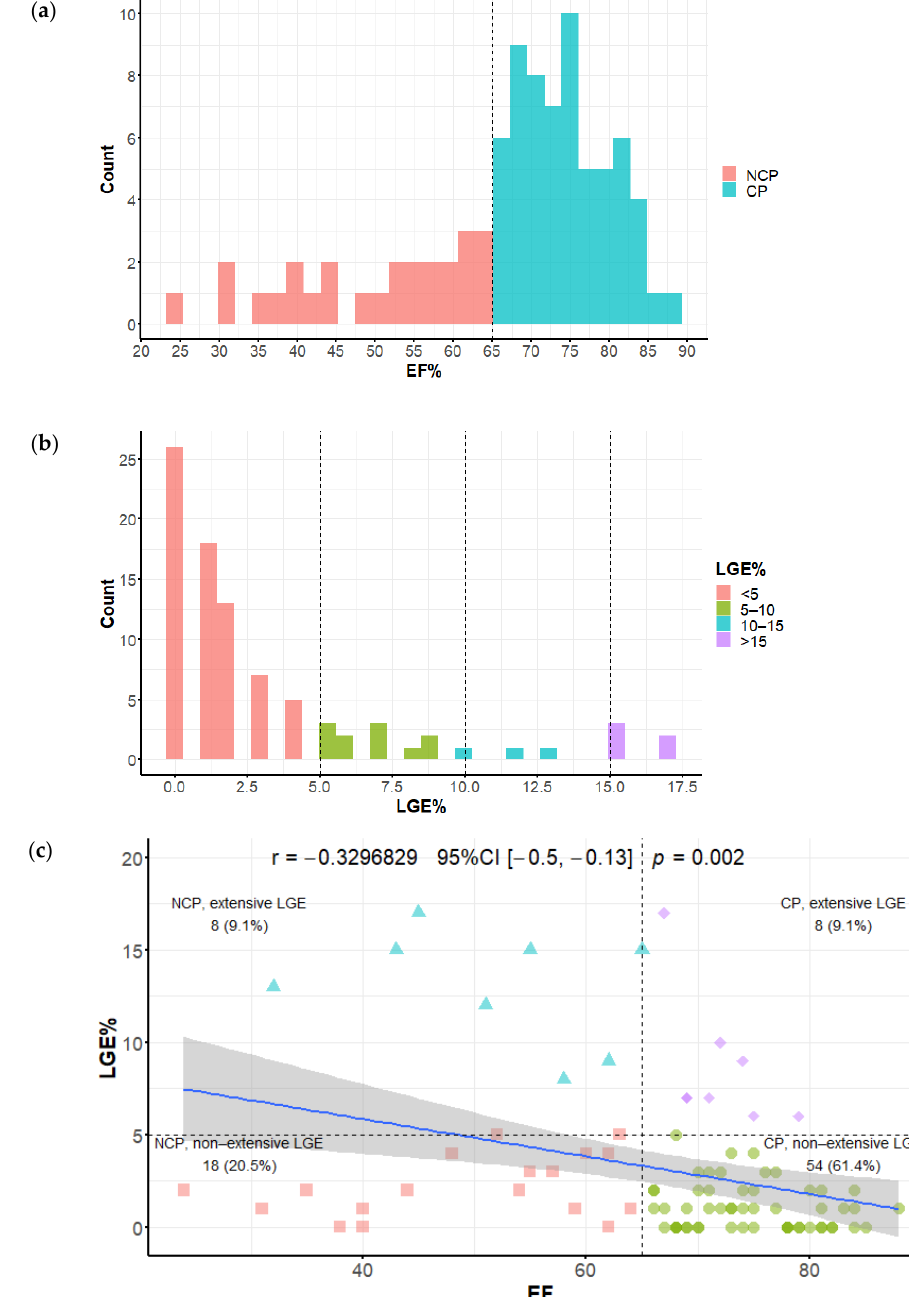
Figure 4. ( a ) EF (ejection fraction) distribution in the study group, EF = 65% was the cutpoint splitting the study subgroups into NCP (nonclassic phenotype) and CP (classic phenotype); ( b ) quantitative LGE (late gadolinium enhancement) distribution among the study groups. ( c ) Correlation of EF and LGE% (late gadolinium enhancement expressed as the percent of myocardial mass); LGE% = 5 and EF = 65% split the patient group into four quarters. Table 2. Left ventricular segmental mean myocardial thickness and segmental distribution of late enhancement areas—comparison between the nonclassic and classic phenotype.